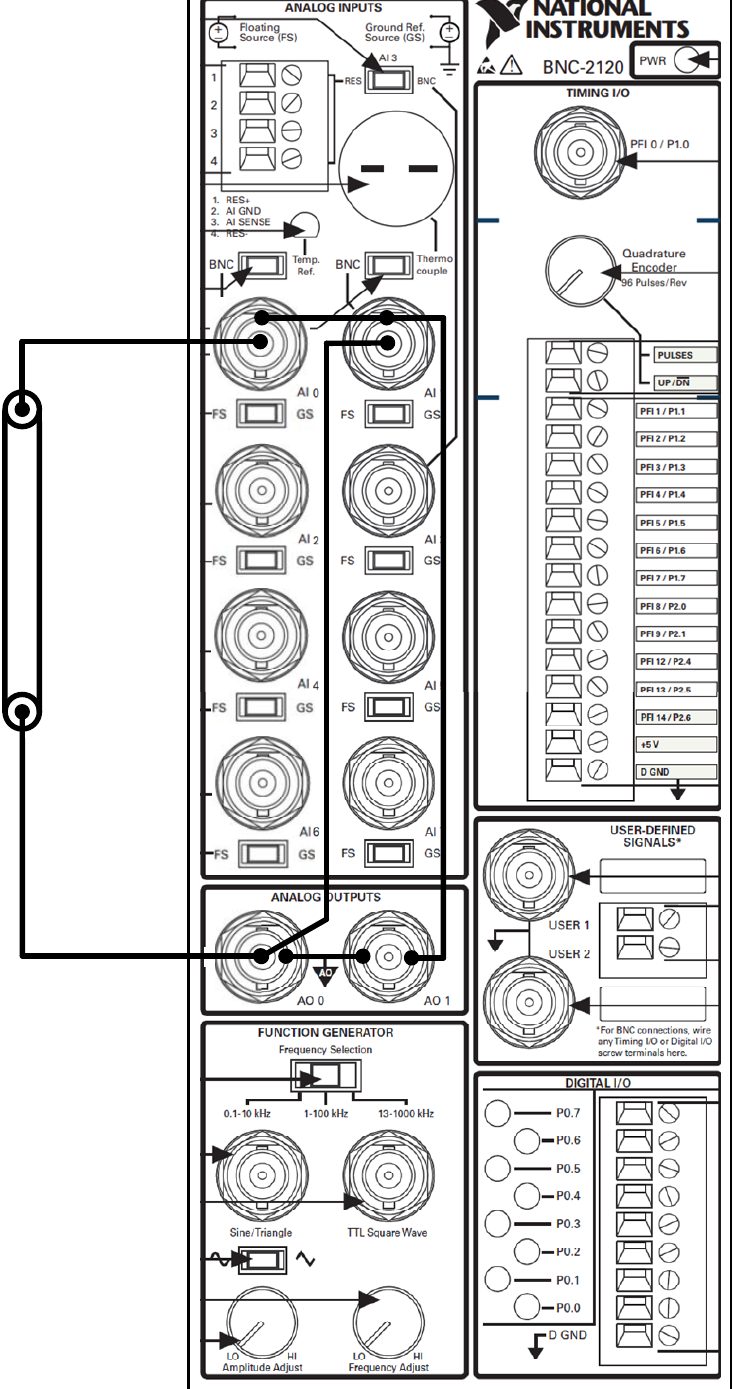
Figure 3. Connection diagram of the BNC ‐ 2120 module with ABE wire.